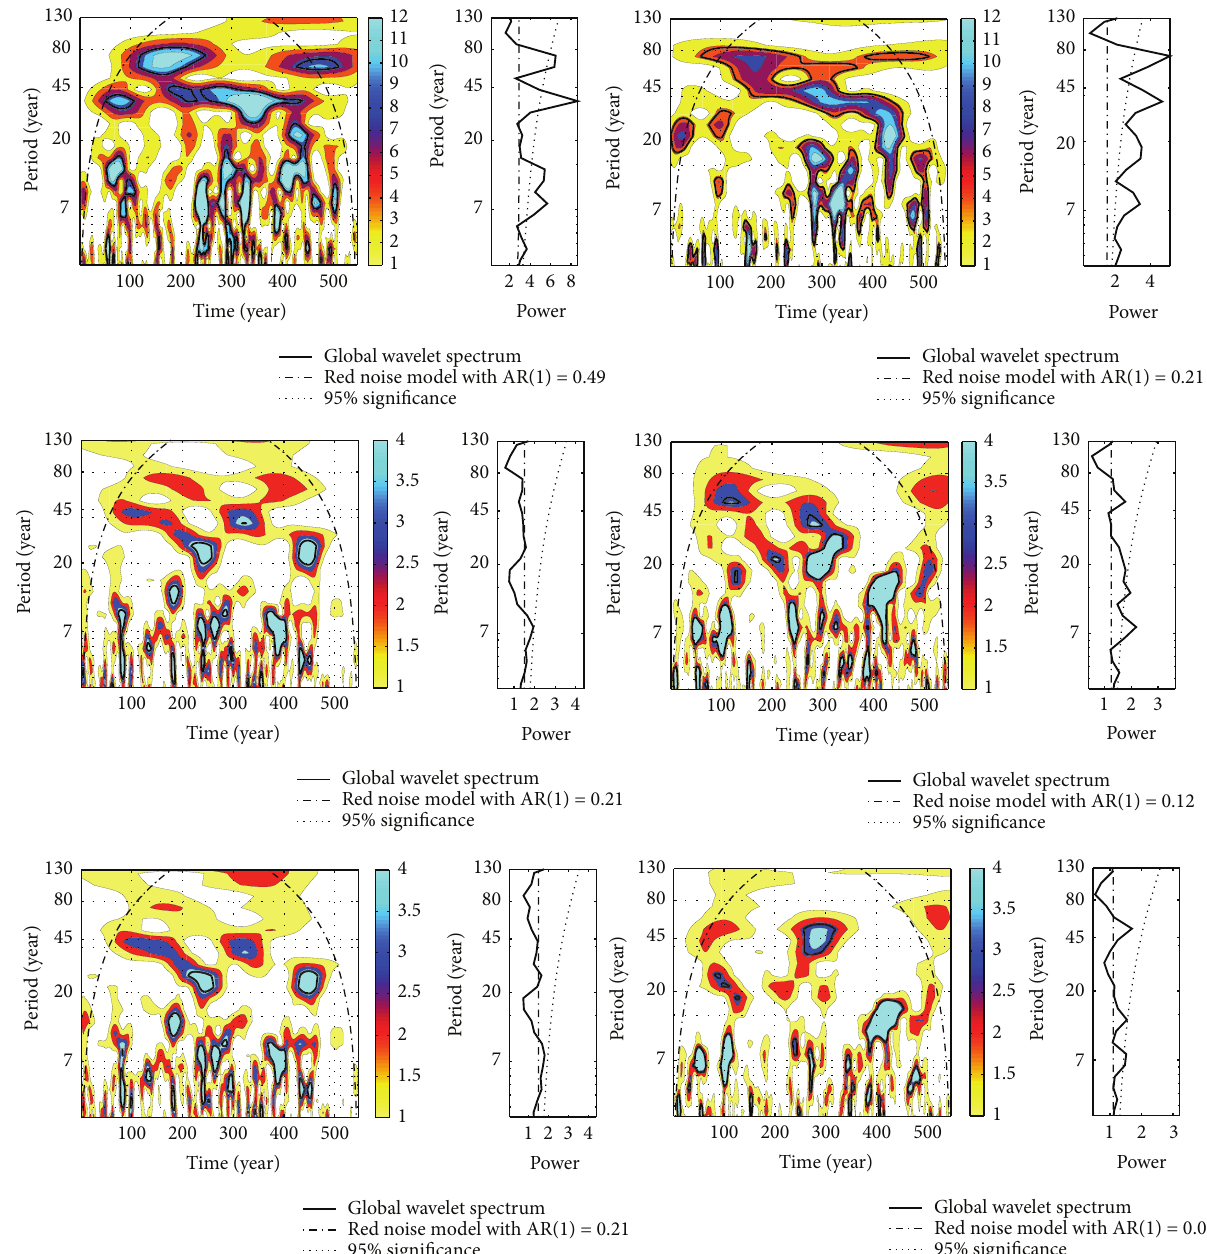
Figure 9: (First column) global and (second column) local wavelet power spectra for the monthly averaged PC 1 of the geopotential height of the (top) 167hPa, (middle) 500 hPa, and (bottom) 833 hPa model level. The contour lines give information on the relative power at a certain scale and a certain time. At both ends, dash-dotted lines separate regions where edge effects become important. The thick black contour envelopes areas of greater than 95% confidence for a corresponding red noise process. (Third column) global and (fourth column) local wavelet spectra for the monthly averaged PC 2 of the geopotential height of the (top) 167 hPa, (middle) 500 hPa, and (bottom) 833 hPa model